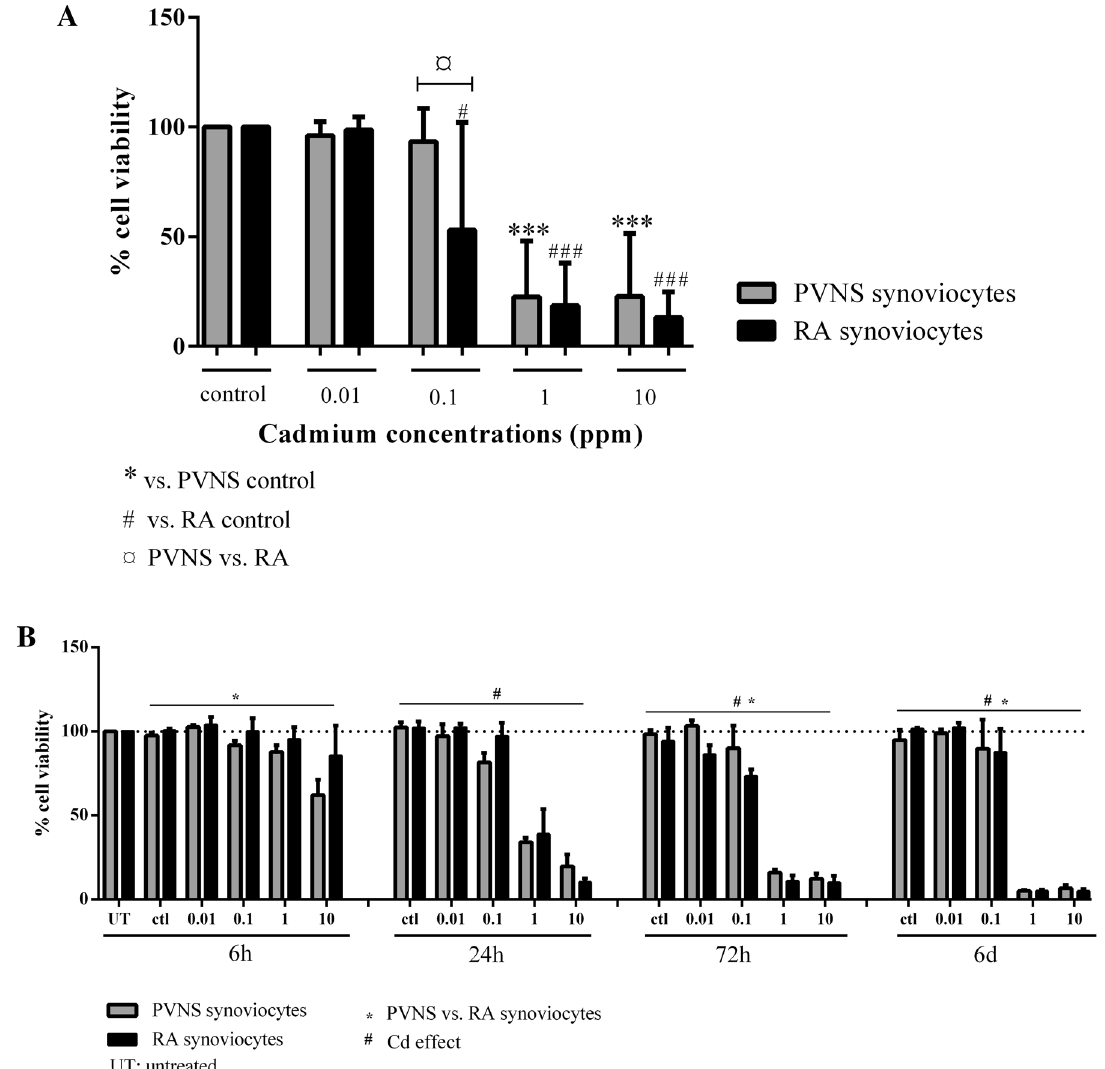
Figure 2. Quantification of cell viability of PVNS and RA synoviocytes 6 days after Cd exposure. PVNS and RA synoviocytes, used between passages 4 to 9, were treated with increasing concentrations of Cd (0.01 ppm; 0.1 ppm; 1 ppm and 10 ppm; ( A ), n = 12 from 6 PVNS patients and 6 RA patients) and, in independent experiments, following kinetics (6 h, 24 h, 72 h and 6 days; ( B ), n = 3 from 3 PVNS patients and 3 RA patients). A quantification of cell viability was done by neutral red assay 6 days after Cd exposure of synoviocytes ( A ) or following kinetics ( B ). Results are presented as mean ± SD, * p <